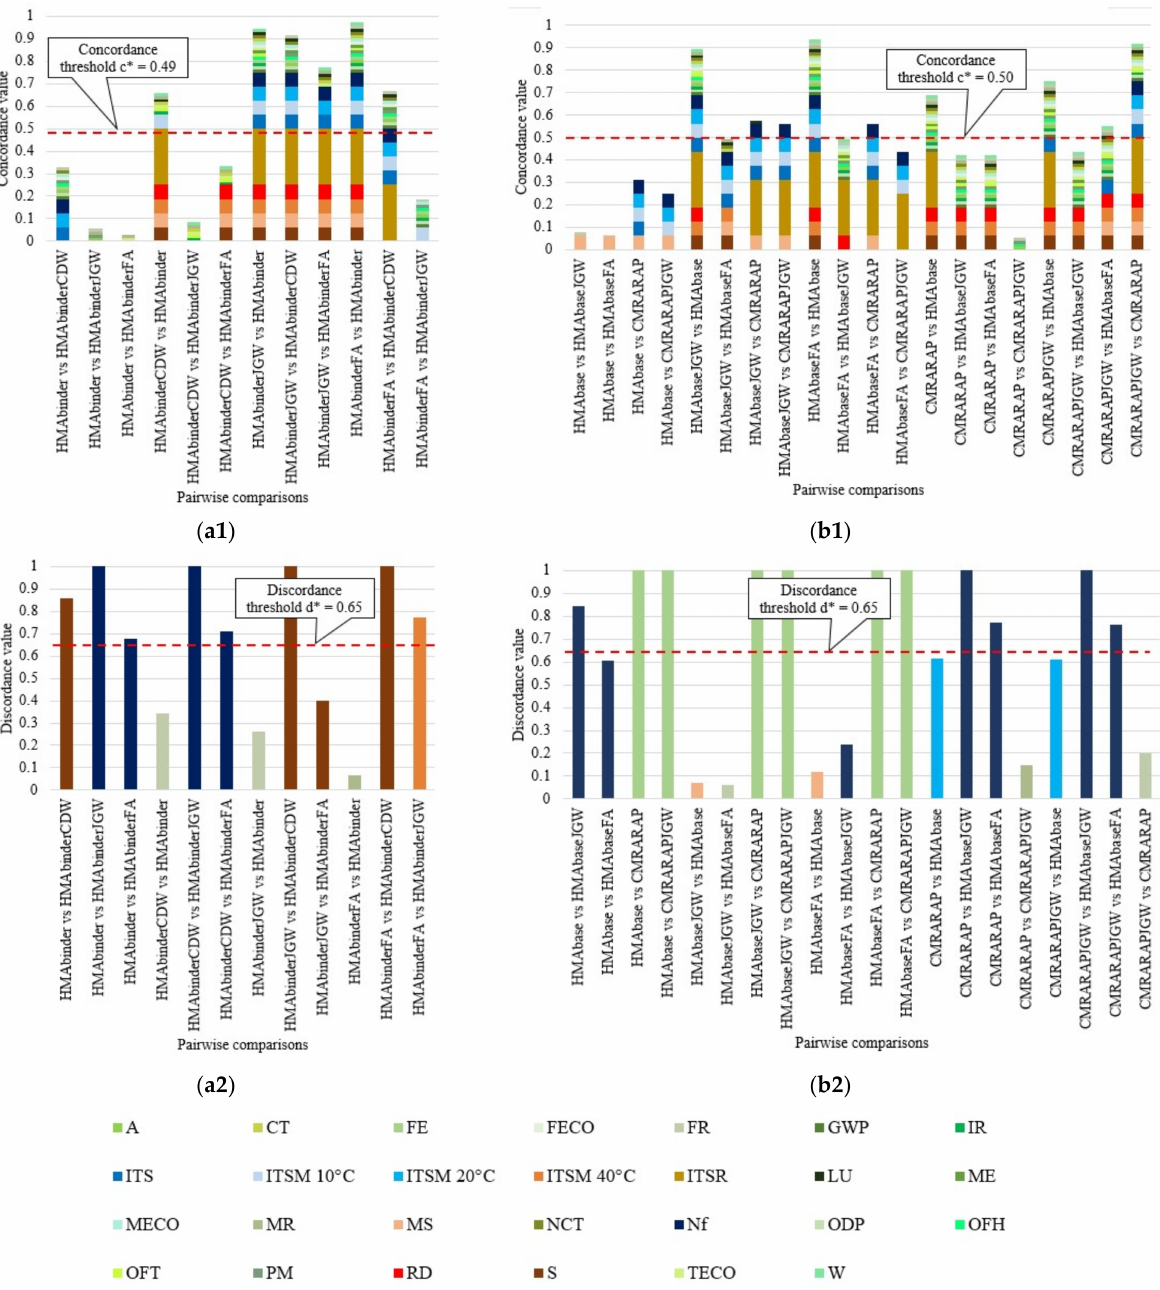
Figure 3. Comparing alternatives: concordance indices and their relative thresholds determined for the ( a1 ) binder layer and ( b1 ) base layer; discordance indices and their relative thresholds obtained for the ( a2 ) binder layer and ( b2 ) base